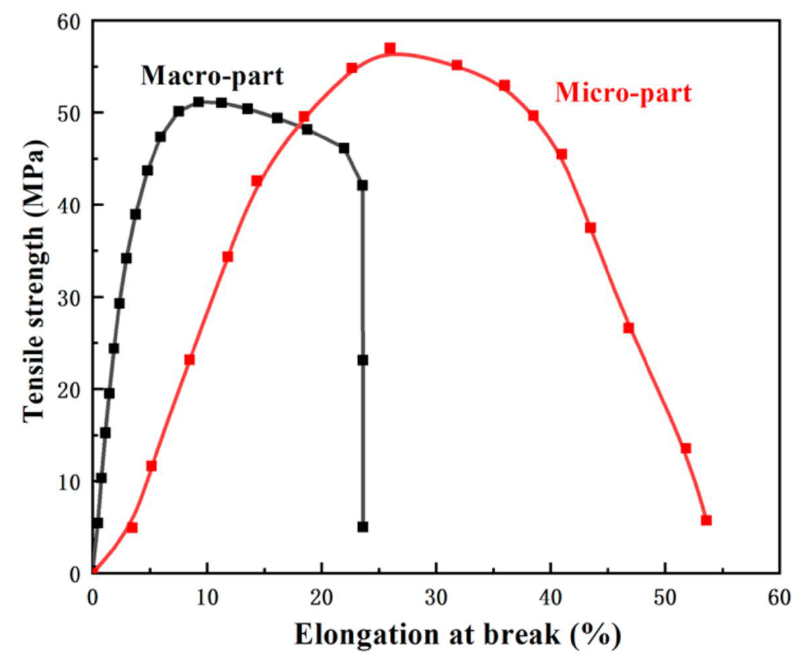
Figure 13. Stress-strain curves of PVDF/GP macro- and micro-parts (GP content: 1